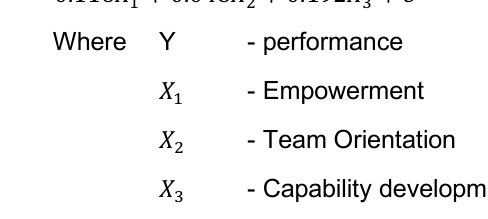
The coefficient of all the constructs on performance were found to be significant as shown. The path coefficients estimates of involvement constructs Empowerment, Team orientation and Capability development had critical ratios (CRs) -2.829, 2.301 and 3.502 respectively whos absolute values are all greater than the tabulated 1.96 Z score at 0.05 level of significance thus implying significant coefficient estimates. The results yields the eqution